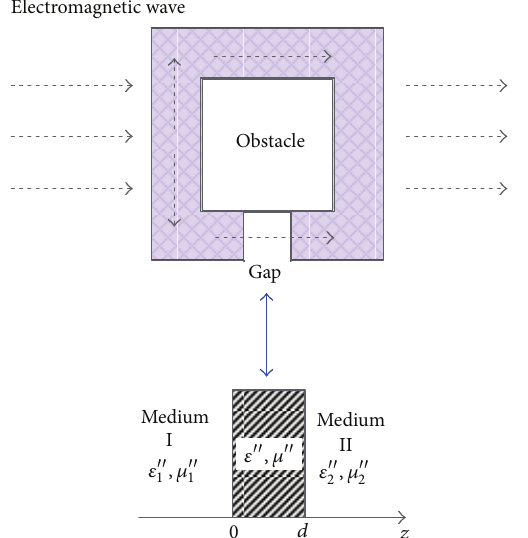
Figure 8: The situation of gap in the bottom of cloak.